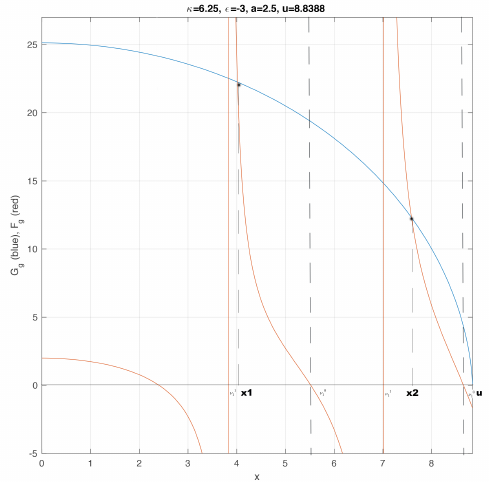
Figure 3: Graphs show the location of the first two roots of DE (9) w.r.t. x corresponding to higher-order symmetric surface waves for κ = 6 . 25 , (cid:15) = − 3 , a = 2 . 5 , u = 8 . 8388 .